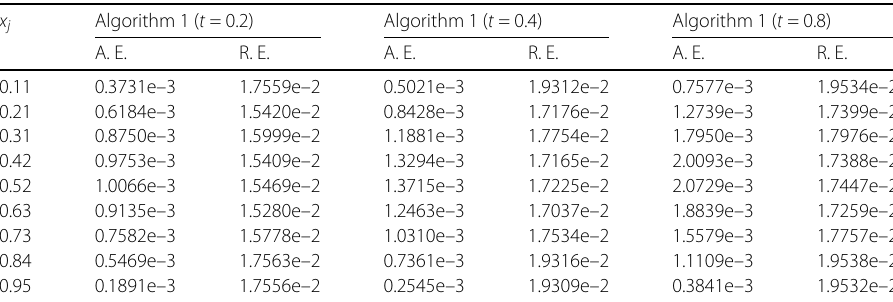
Table 2 The absolute errors and relative errors of numerical solutions to Example 1 for h = 1/19 (i.e.,